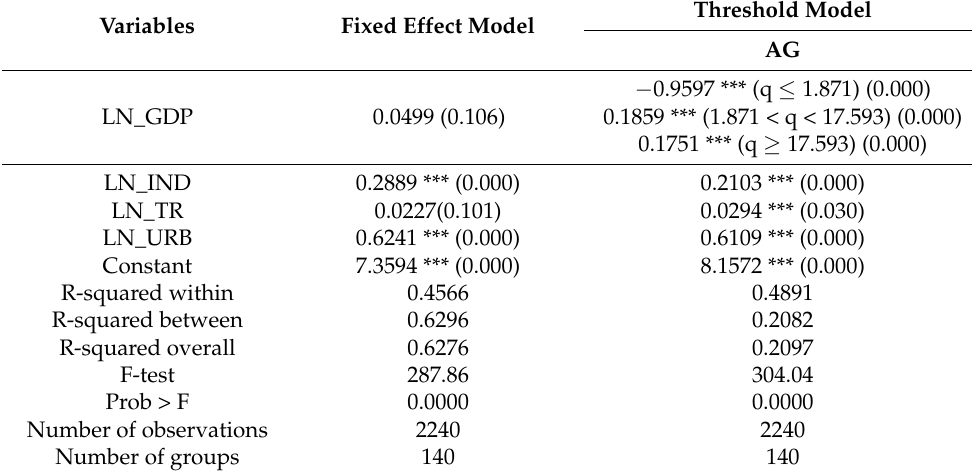
Table 6. Regression results of threshold model and fixed effect model.